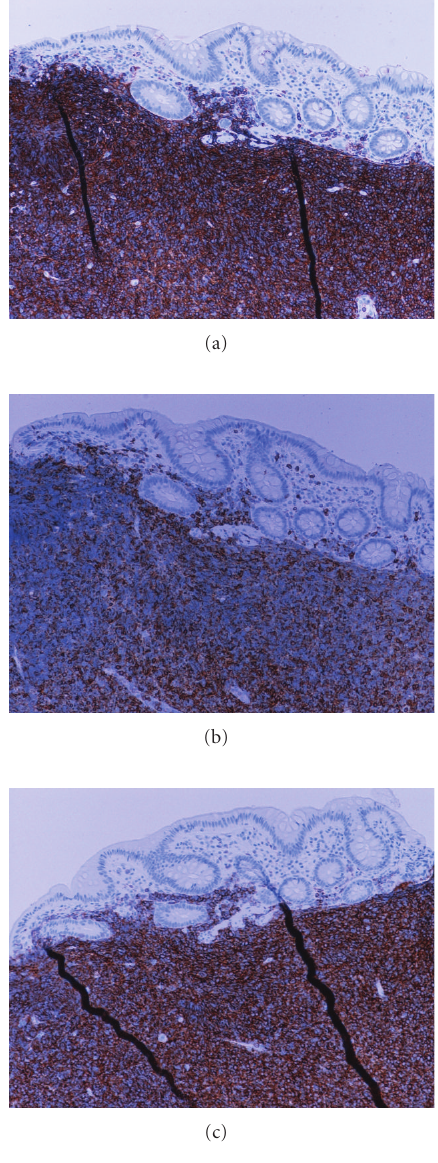
Figure 1: Biopsy specimens revealed multiple di ff use CD20 positive (a) B-cell infiltrates involving mucosa and submucosa of colon without formation lymphoepithelial lesions. B-lymphocytes expressed also CD5 with low intensity (b) and CD23 (c), character- istic of small lymphocytic lymphoma